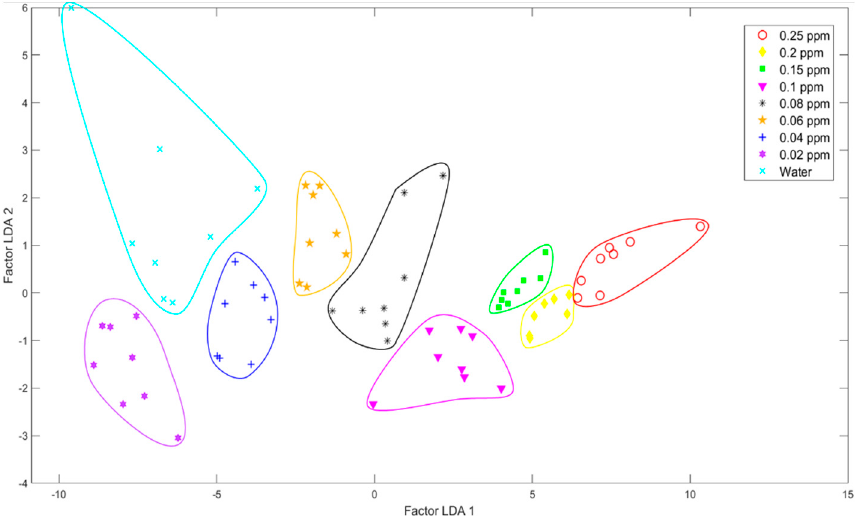
Figure 12. LDA plot by employing the carbon electrode (C110) for the Nativo pesticide classification at different concentrations.